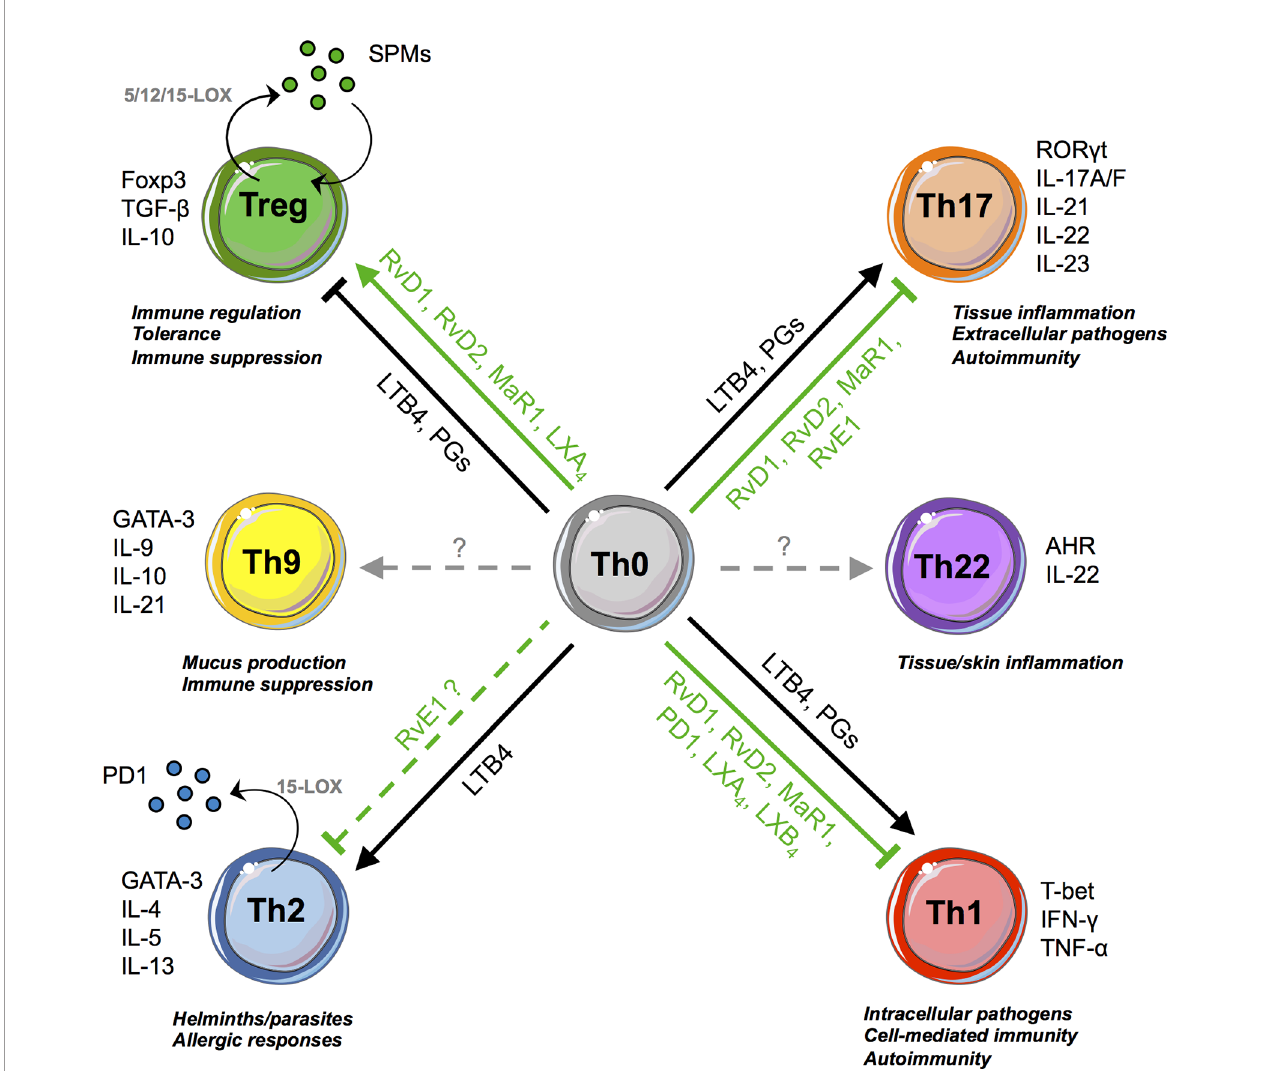
FIGURE 2 | SPMs and T-cell responses. SPMs and pro-in fl ammatory lipids promote or inhibit, in opposite ways, T-cell differentiation (from Th0 precursors to Tregs, Th1, Th2, Th17). Th2 and Treg cells are also able to biosynthesize few SPMs, such as 17R-RvD3, RvD4, MaRn-3DPA, and PD1,